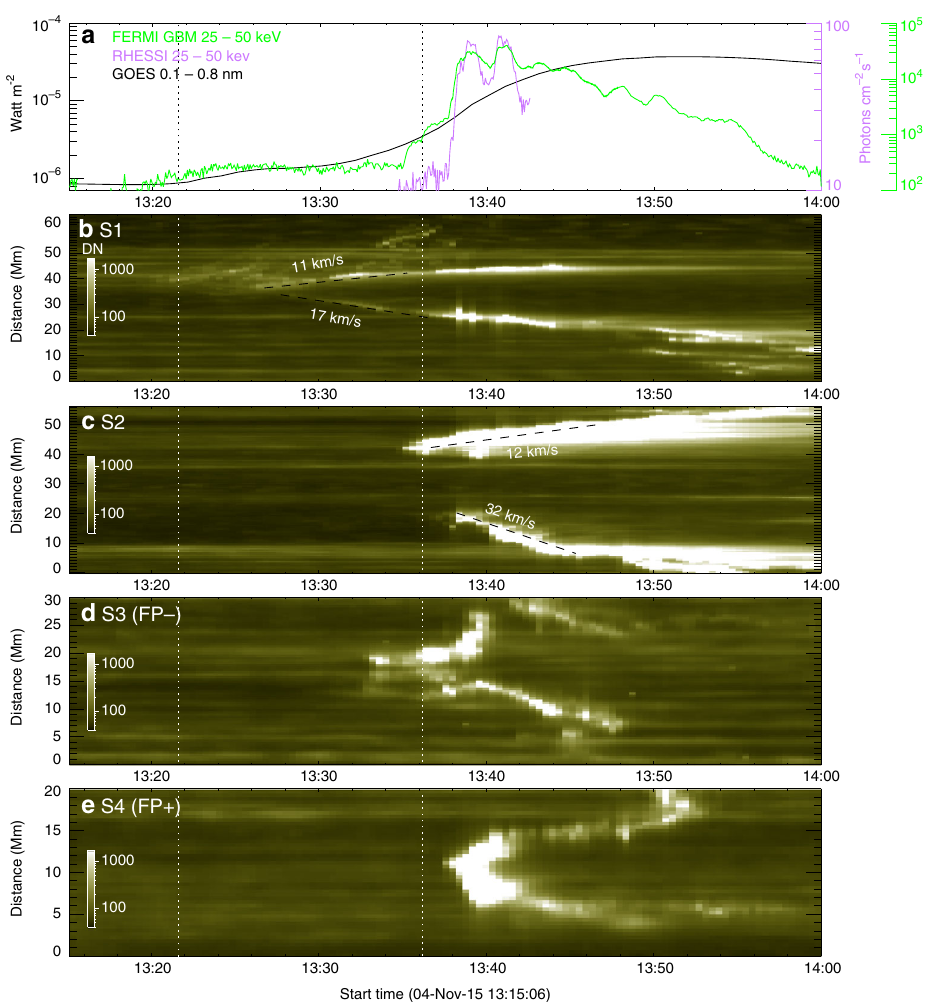
Fig. 3 Temporal evolution of the fl are ribbons in 1600 Å. a Shows 0.1 – 0.8 nm soft X-ray fl ux observed by the Geostationary Operational Environmental Satellite (GOES), 25 – 50 keV hard X-ray (HXR) count rate observed by the Gamma-ray Burst Monitor (GBM) onboard the Fermi Gamma-Ray Space Telescope, and 25 – 50 keV HXR photon fl ux observed by the Reuven Ramaty High-Energy Solar Spectroscopic Imager (RHESSI). b – e Show the evolution of the fl are ribbons as seen through slits S1 and S2 indicated in Fig. 2a, and of the bright rings as seen through slits S3 (for FP − ) and S4 (for FP+) indicated in Fig. 2b, f, respectively. The fi rst vertical dotted line marks the onset of the fl are with the initial appearance of fl are ribbons; the second line marks the onset of the fl are main phase characterized by rapid ribbon separation c and non-thermal HXR production